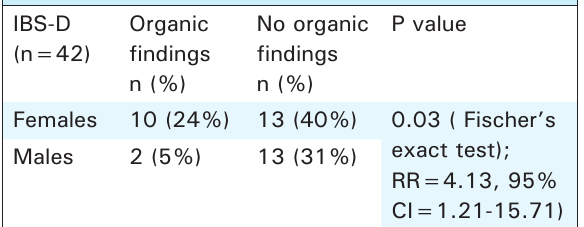
Table 1. Gender distribution in patients with IBS-D based on organic